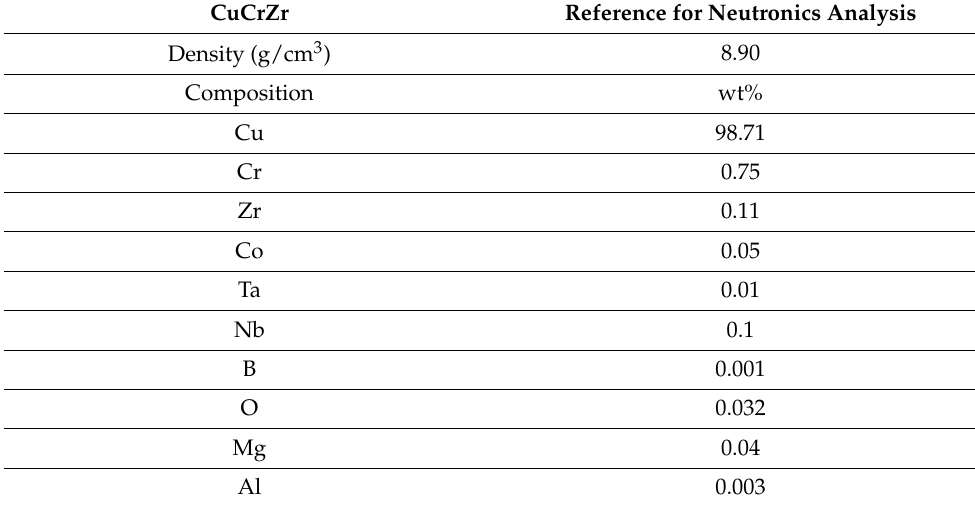
Table 5. Reference CuCrZr alloy composition used for neutronics analyses